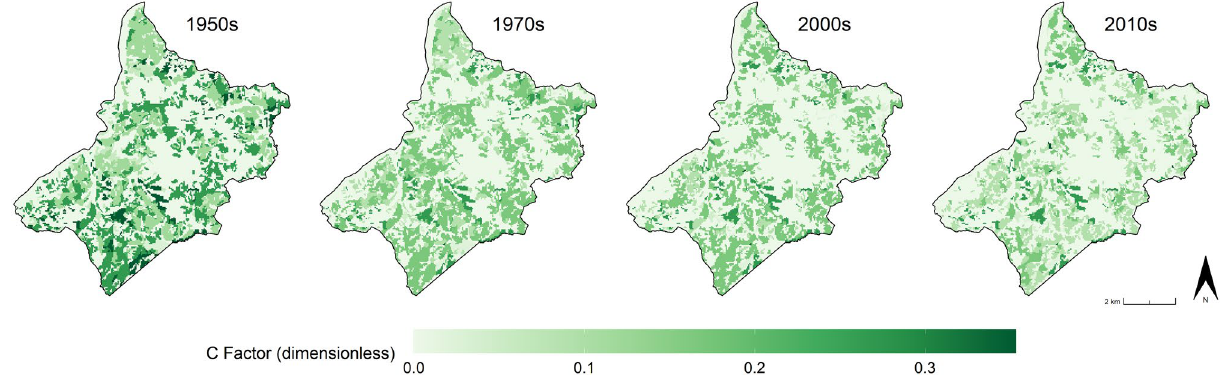
Figure 6. The cover management (C) factors calculated for the four chronological periods: 1950s, 1970s, 2000s, 2010s). Image generated with software RStudio Desktop 2022.07.2 + 576 (https:// www. rstud io.